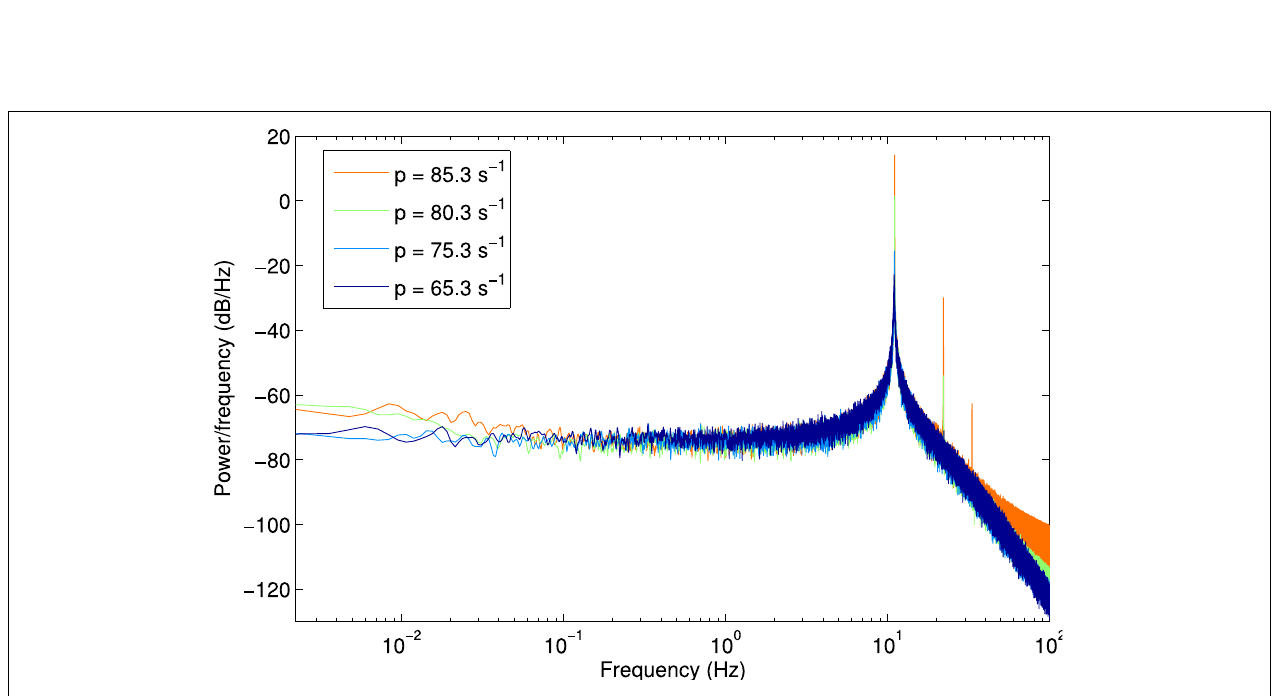
FIGUREA4 | Power spectrum for scenario H3u, using a larger window size of 450s (2,250,000 samples) to show lower frequencies from 2.2 × 10 − 3